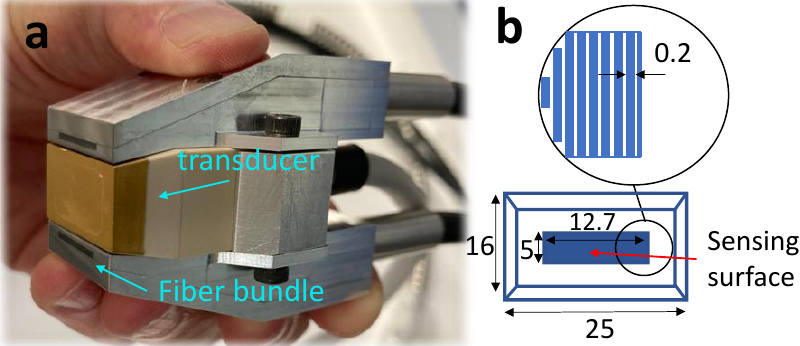
Figure 2. ( a ) A photograph of the assembled optoacoustic probe, ( b ) and a face illustration of the ultrasound transducer. The dimensions are shown in millimeters.